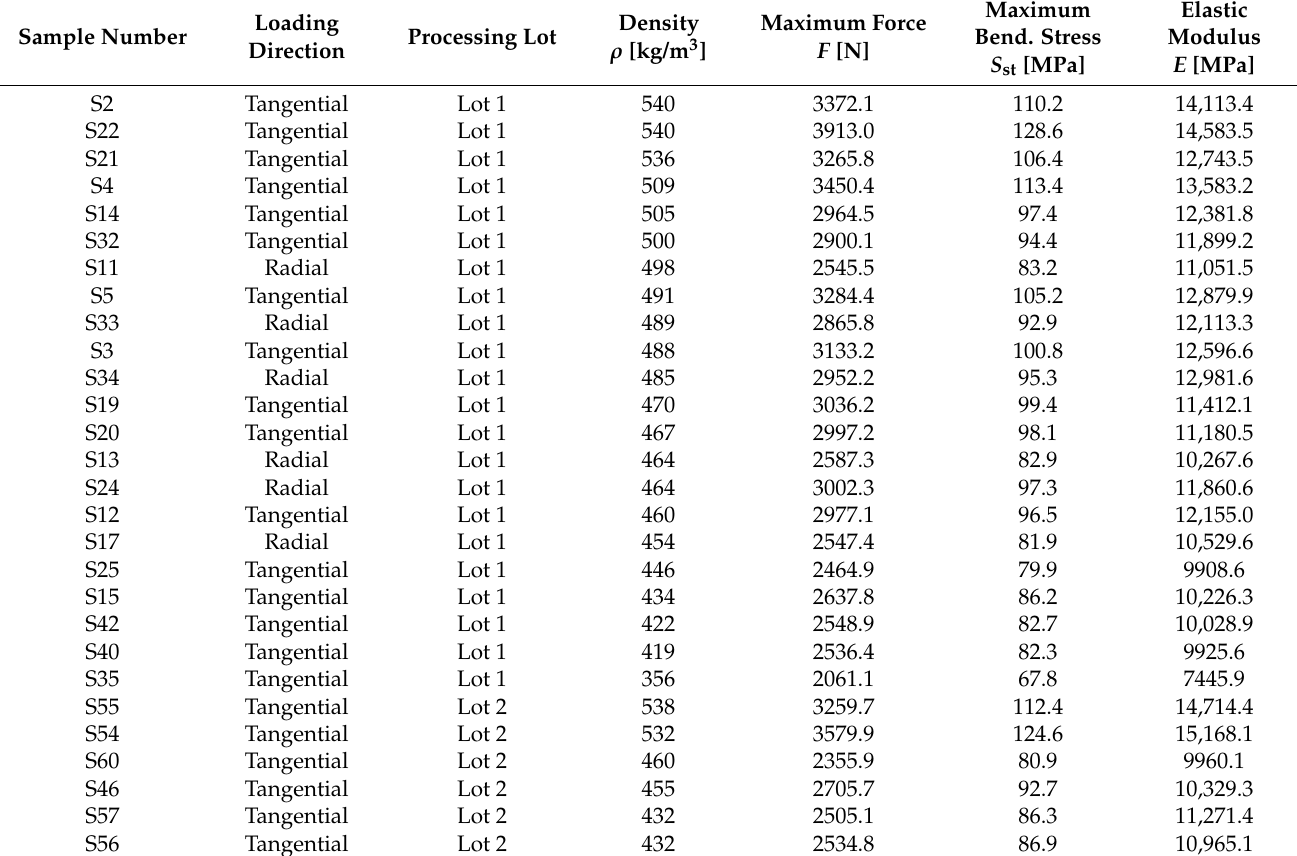
Table 1. Specimen data with the results of the static three-point bending